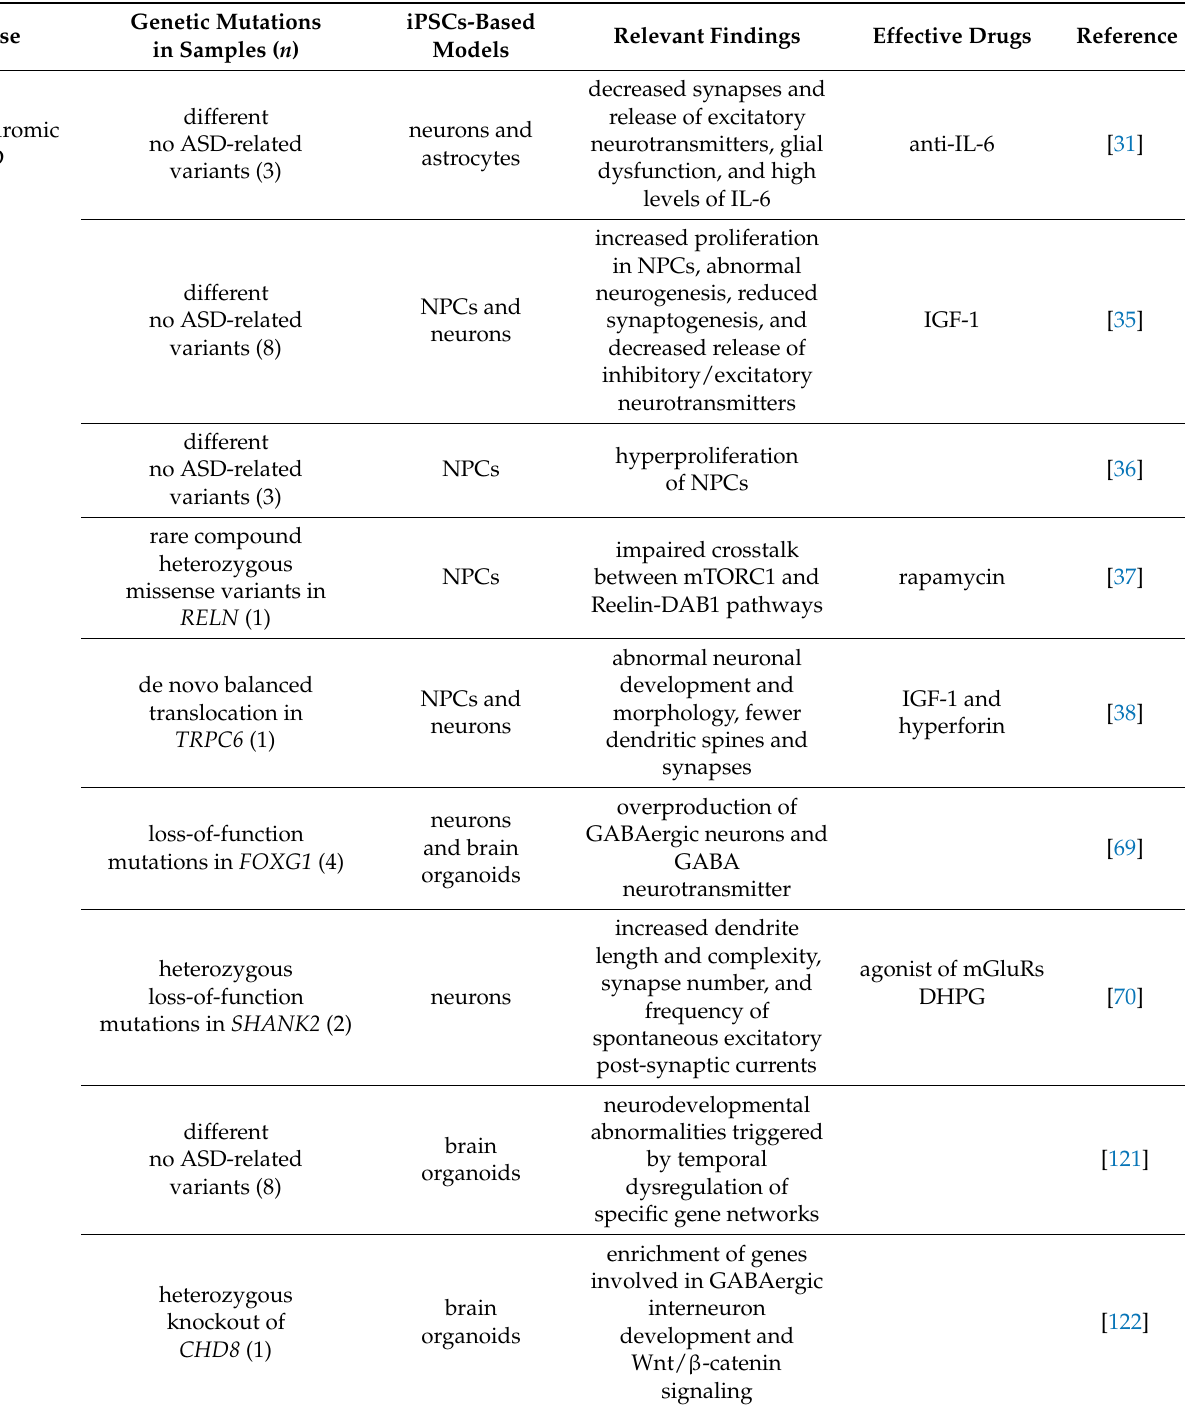
Table 2. Summary of main iPSCs-based studies as a model of